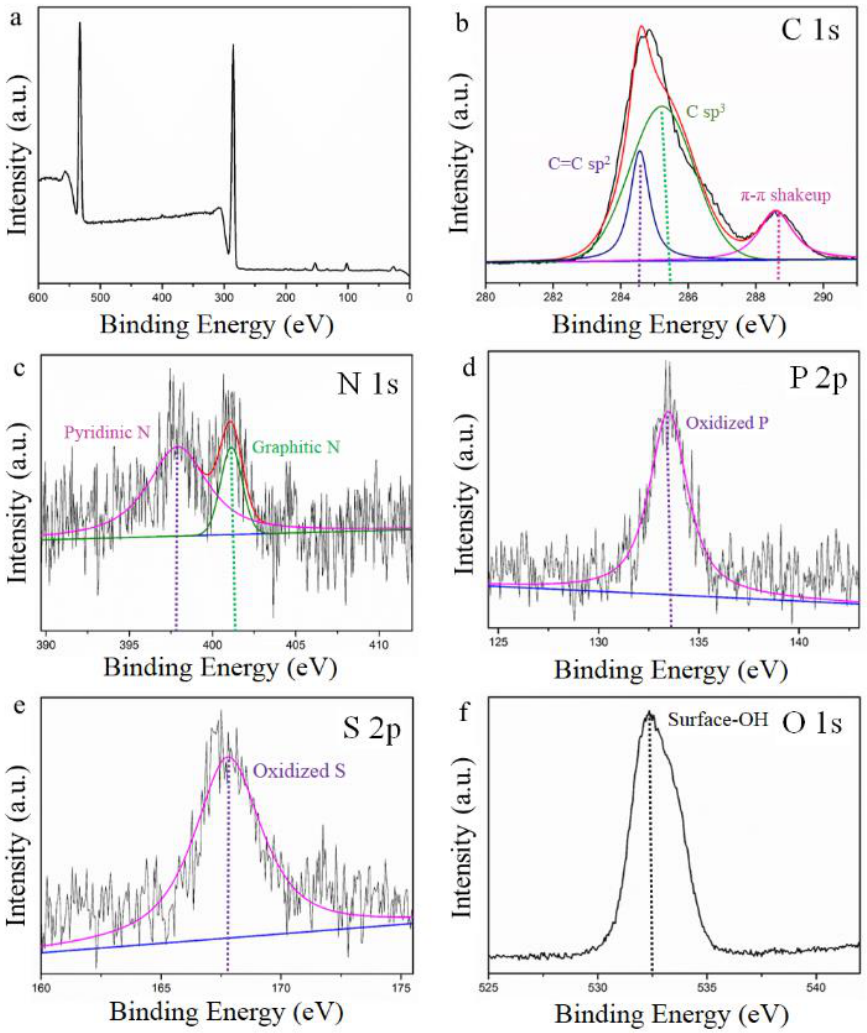
Figure 5. XPS spectra of ( a ) PZS@rGO8%, ( b ) C 1s, ( c ) N 1s, ( d ) P 2p, ( e ) S 2p and ( f ) O 1s. The surface area and structure of the PZS@rGO8% were explored by N 2 absorption- desorption isotherms (Figure S2). PZS@rGO8% showed the type IV isotherms with H3- shaped hysteresis loops [44], which is a characteristic of mesoporous materials. The relative pressure of 0.451–1.0 is indexed to the mesoporous structure and the slit-shaped hole in the material [45]. The adsorbent exhibited a high surface area of 443 m 2 /g, which is considerably higher than the surface area of the PZS microsphere, 10.5 m 2 /g